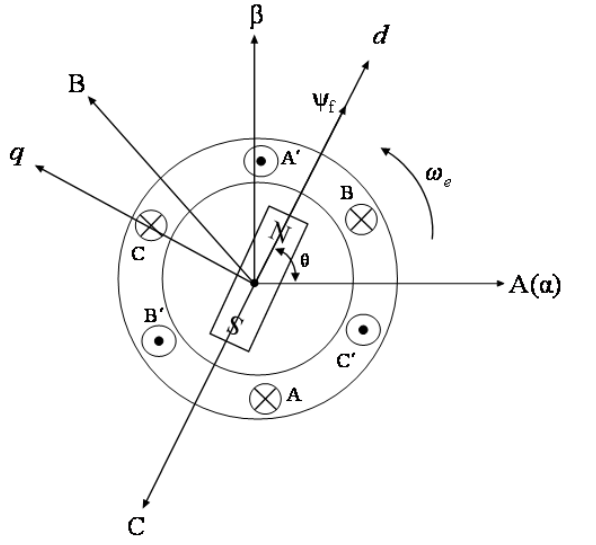
Figure 2. Mathematical model of permanent magnet synchronous